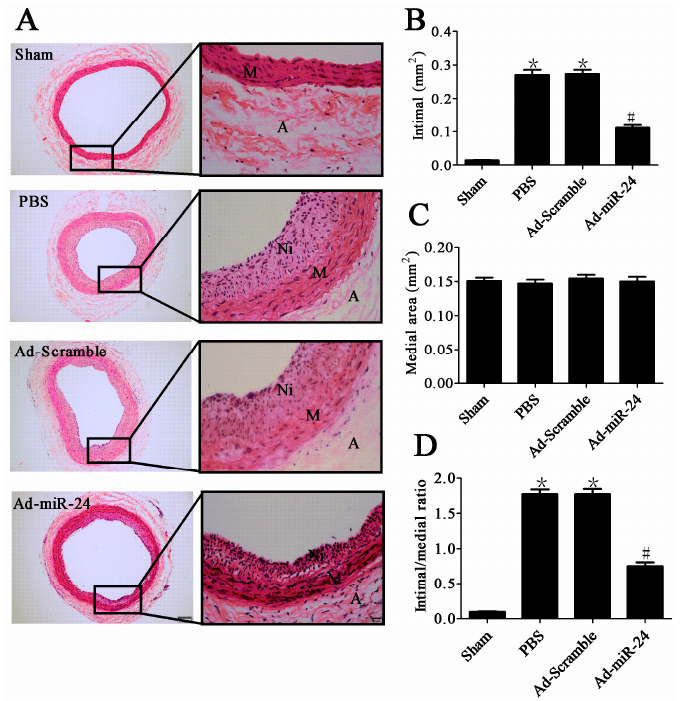
Figure 3. Effects of miR-24 on neointimal formation at two weeks after vascular injury and gene delivery: ( A ) Representative cross-sections of hematoxylin-eosin (HE) in different groups. Left (100× magnification, scale bar represents 100 μ m), right (400× magnification, scale bar represents 20 μ m); ( B , C ) Quantitative analysis of the neointimal formation (compared to Sham group, * p < 0.05; compared to PBS group or Ad-Scramble group, # p < 0.05, n = 6); ( D ) Ratio of intima to media (compared to Sham group, * p < 0.05; Compared to PBS group or Ad-Scramble group, # p < 0.05, n = 6). A: Adventitia; M: Media; Ni: Neointima.